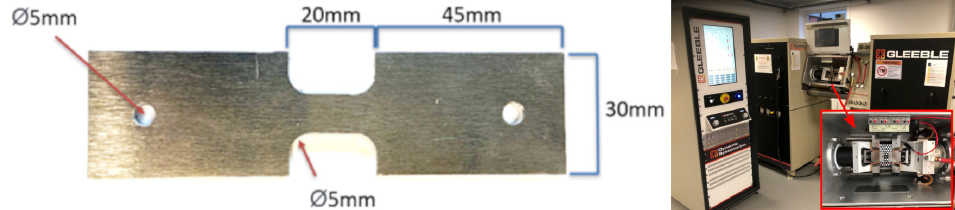
Figure 1. Sample geometry used for Gleeble thermomechanical processing, and Gleeble 3800 test machine (Gleeble, Poestenkill, NY, USA).